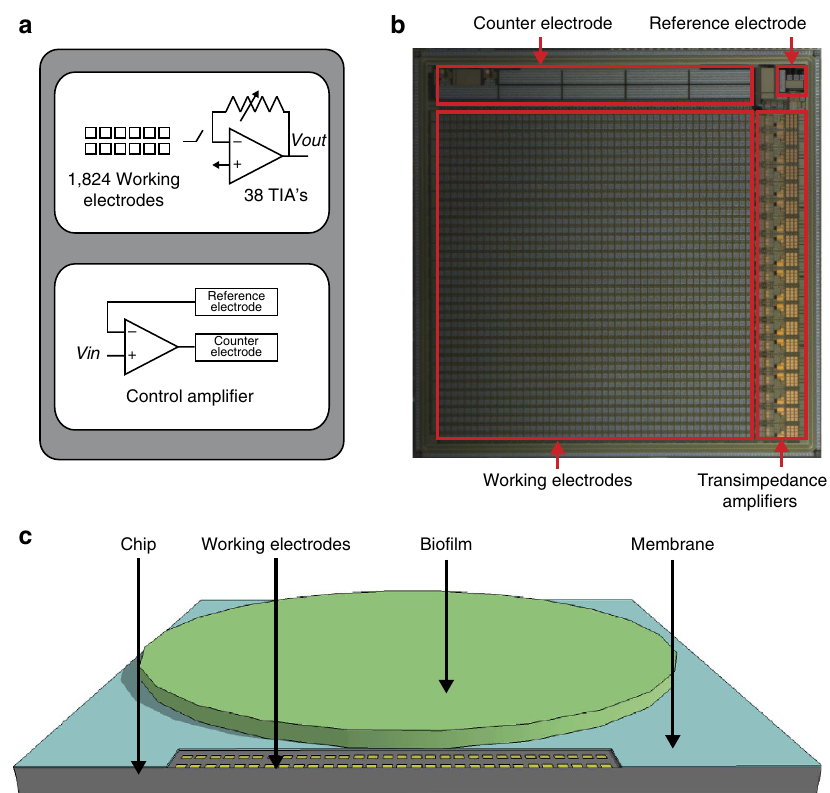
Figure 2 | Electrochemical camera imaging platform. ( a ) Block diagram of the electrochemical camera chip. ( b ) Optical micrograph of the electrochemical camera chip with integrated electrodes and amplifiers highlighted. Chip is 1cm x 1cm. ( c ) Diagram of the imaging platform with the electrochemical camera chip, working electrodes, biofilm and membrane